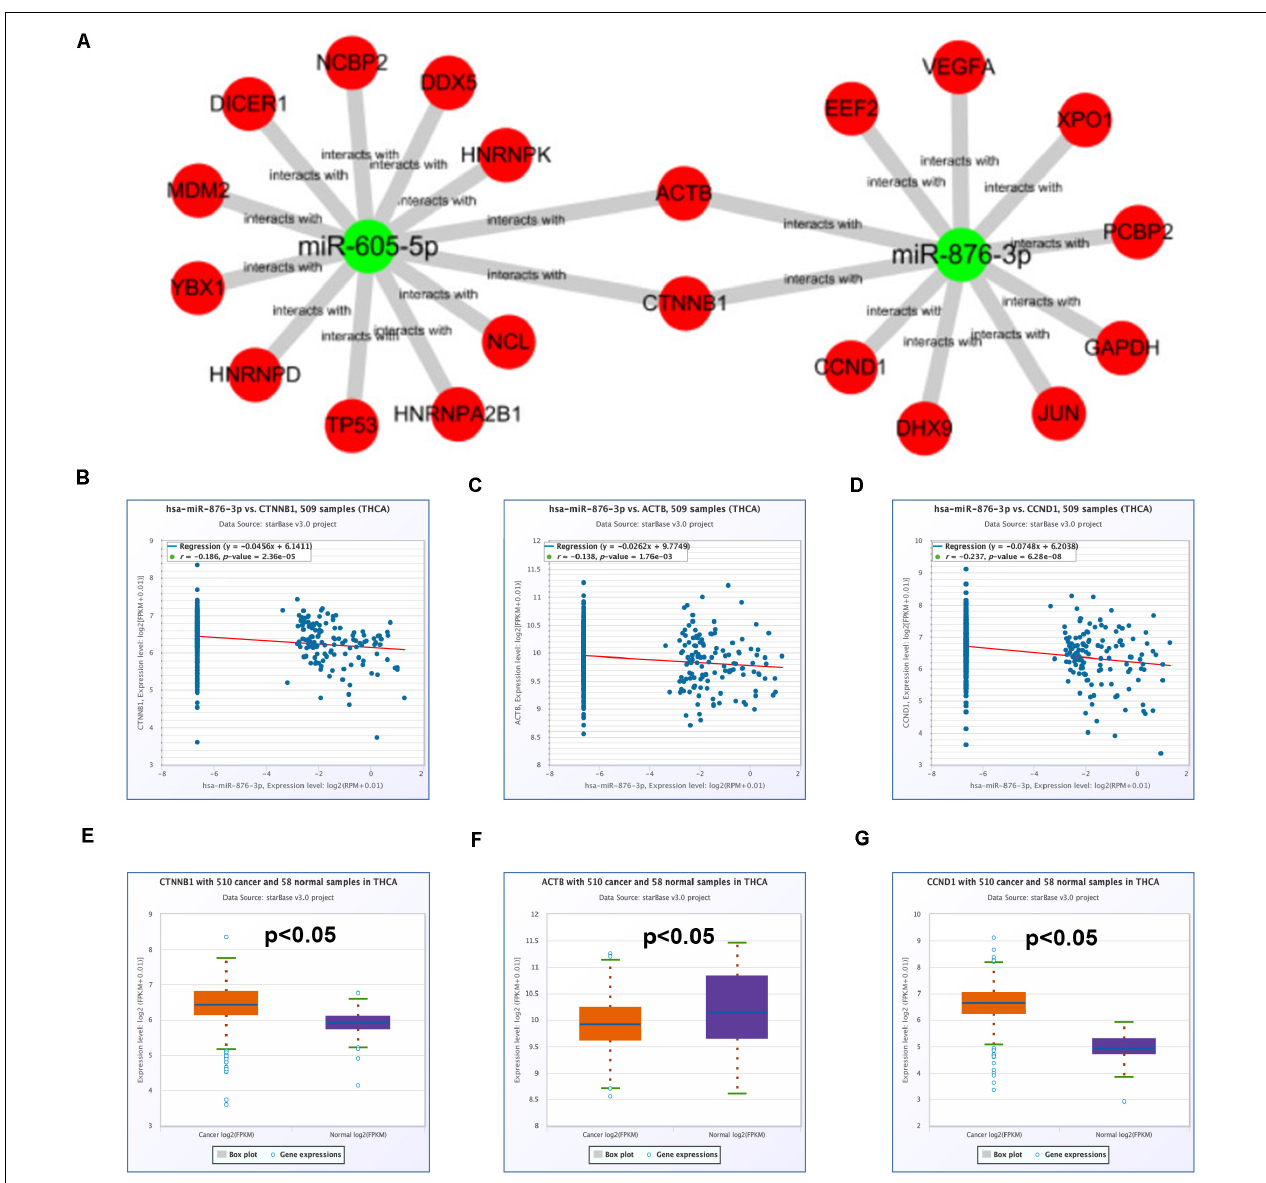
FIGURE 7 | Identification of potential target genes of miR-605-5p and miR-876-3p in thyroid carcinoma. (A) The miRNA–hub gene network established by Cytoscape software. (B) The expression correlation of miR-876-3p with CTNNB1 in thyroid carcinoma. (C) The expression correlation of miR-876-3p with ACTB in thyroid carcinoma. (D) The expression correlation of miR-876-3p with CCND1 in thyroid carcinoma. (E) The mRNA expression level of CTNNB1 in thyroid carcinoma. (F) The mRNA expression level of ACTB in thyroid carcinoma. (G) The mRNA expression level of CCND1 in thyroid carcinoma. “ p < 0.05” was considered as statistically